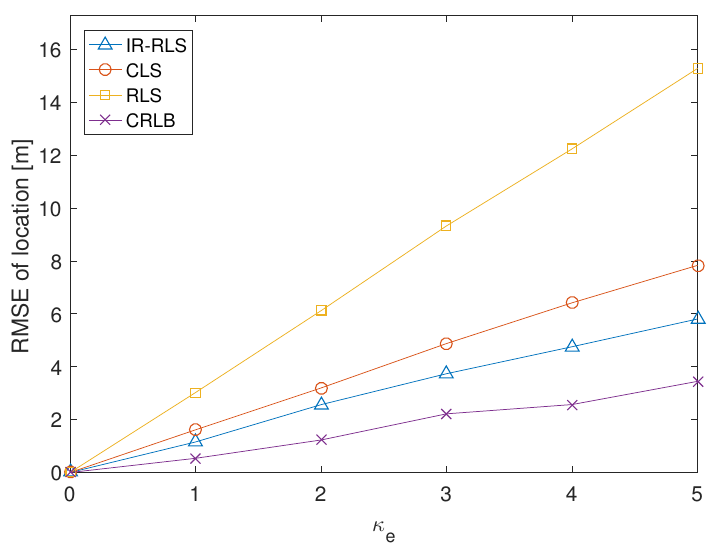
Figure 6. RMSE comparison for proportional noise parameter ( κ e